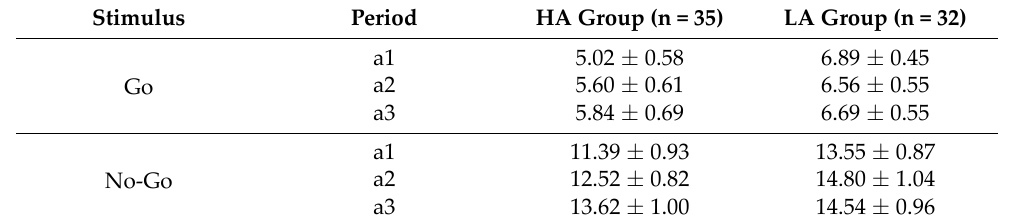
Table 5. Mean amplitudes of the SP ( µ V) (M ± SEM).